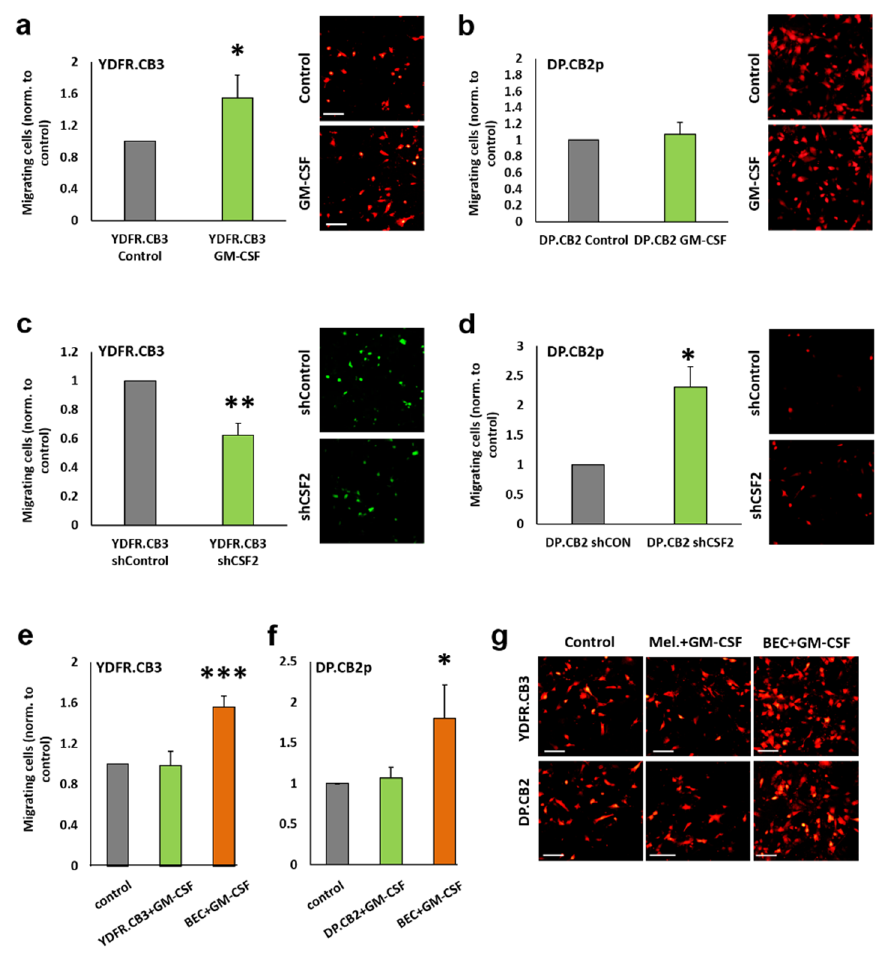
Figure 4. GM-CSF differentially mediates melanoma transendothelial migration. ( a , b ) mCherry-expressing YDFR.CB3 ( a ) and DP.CB2 ( b ) cells migrated through brain endothelial cells(BEC) in the absence (Control) or presence (GM-CSF) of 10 ng/mL rhGM-CSF. ( c , d ) Transendothelial migration of CSF2-silenced YDFR.CB3 ( c ) and DP.CB2 ( d ) cells (shCSF2) and their corresponding control cells (shControl). ( e-g ) Untreated mCherry-expressing YDFR.CB3 ( e , g ) and DP.CB2 ( f , g ) cells migrated through untreated BEC (Control); 10 ng/mL rhGM-CSF pre-treated melanoma cells migrated through untreated BEC (melanoma + GM-CSF); untreated melanoma cells migrated through 10 ng/mL rhGM-CSF pre-treated BEC (BEC + GM-CSF). Representative images for